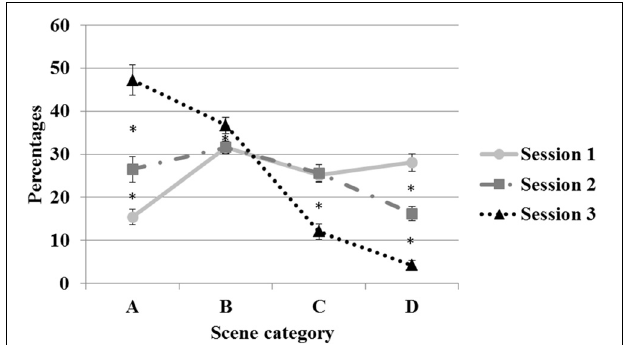
FIGURE 2 | Percentages of the scores obtained during simulated moped riding in the three sessions. Error bars represent standard errors. Asterisks indicate the significant differences as attested by the post hoc